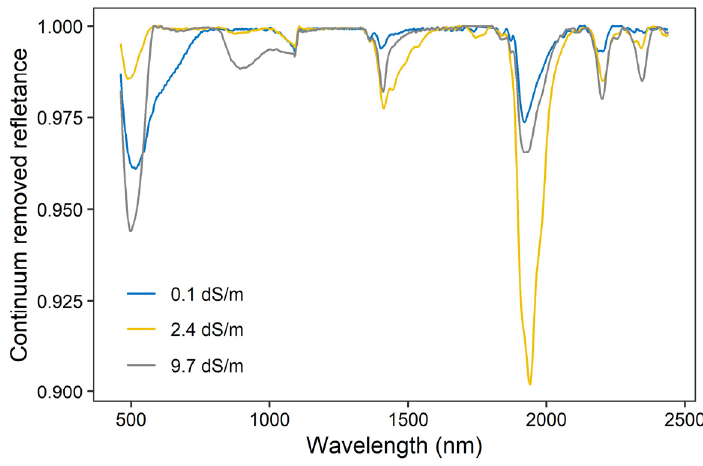
Figure 2. Continuum removed reflectance of three soil samples at different EC contents.